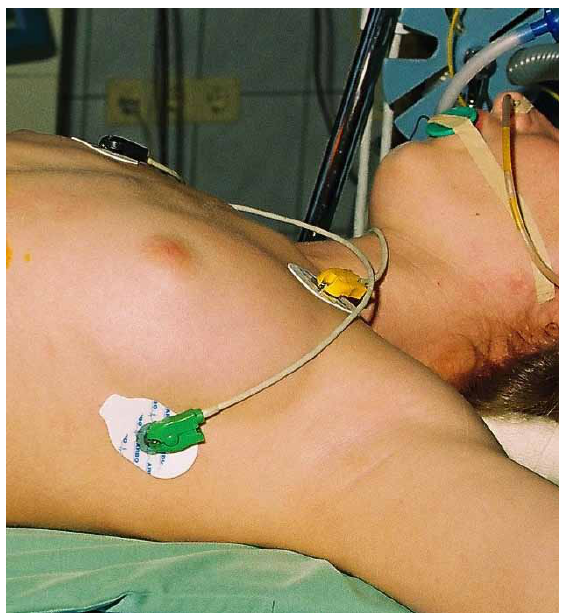
Figure 1. Well developed breast and absence of axillary hair.